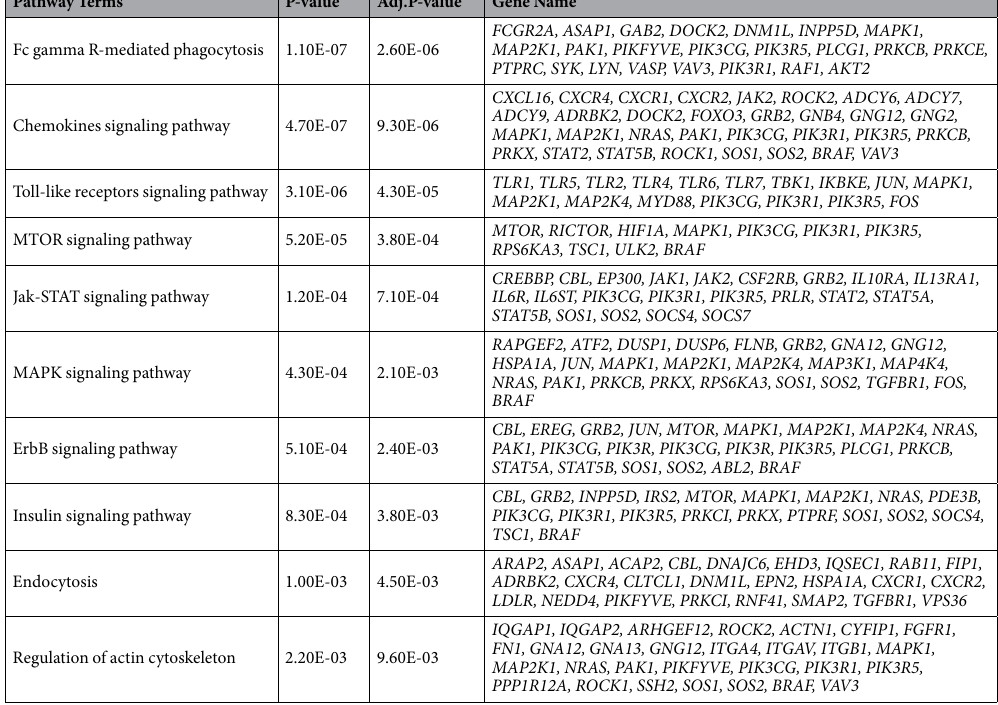
RNA, Myeloid-Specific 1) 26 , DANCR (Differentiation Antagonizing Non-Protein Coding RNA) 27 , GAS5 (Growth Arrest Specific 5) 28 , LINC-PINT (Long Intergenic Non-Protein Coding RNA, P53 Induced Transcript) 29 , HEIH (Hepatocellular Carcinoma Associated Transcript) 30 and RMRP (RNA Component Of Mitochondrial RNA Processing Endoribonuclease) 31 which were upregulated and, TUG1 (Taurine Upregulated 1) 32 , which was down- regulated in XLA patients compared to the healthy subjects. In addition, expression of the 20 DE novel lincRNAs were identified between XLA patients and healthy subjects. Among the 20 DE novel lincRNAs, 5 lincRNAs were upregulated and 15 lincRNAs were downregulated in XLA patients compared to healthy subjects, respectively (Supplementary Table S4). DE lncRNAs co-located with protein-coding genes. lncRNAs have been reported to coordinate the regulation of neighboring protein-coding genes (co-located genes). To identify the potential function of the identified DE lncRNAs, the protein-coding genes which genomic locations within ~5 kb upstream and ~1 kb downstream of the DE lncRNAs and which may extend to 1000 kb in both directions were searched. The anal- ysis revealed that out of 95 DE annotated lncRNAs, 85 lncRNAs were corresponded to 144 protein-coding genes. Moreover, among the 20 DE novel lincRNAs, 18 novel lincRNAs were linked to 28 protein-coding genes (Supplementary Table S5). Majority of DE lncRNAs region-gene associations were found to be dis- tal binding events while approximately only 9% regions were within 5 kb of transcription start sites (TSS) (Supplementary Fig. S1). Next, the function of DE lncRNAs was examined based on GO enrichment and KEGG pathway analysis of their co-located genes (Fig. 4, Supplementary Table S2). The GO enrichment analysis based on biological process demonstrated that the DE annotated lncRNAs co-located genes were mainly involved in “reproductive process”, “positive regulation of cell proliferation” and “induction of apoptosis by extracellular signals” (Fig. 4a). On the other hands, the DE novel lincRNAs co-located genes were related to “regulation of cell differentiation” and “regulation of cell activation” (Fig. 4b). The KEGG pathway analysis revealed that the DE annotated lncRNAs co-located genes were significantly involved in “Metabolic pathways”, and “Cytokine- cytokine receptor interac- tion” (Fig. 4c). While the novel lincRNAs co-located genes were related to “Focal adhesion” and “Regulation of actin cytoskeleton” (Fig. 4d). Besides that, we examined whether any DE lncRNAs co-located genes was differentially expressed in XLA patients compared to healthy subjects. The comparison of the DE annotated and novel lncRNAs co-located genes with DE protein-coding genes led to identification of 23 genomically co-located DE protein-coding genes (Supplementary Table S6). For instance, DE annotated lncRNAs; HOTAIRM1 , DANCR and GAS5 were co-located with DE protein-coding genes: HOXA1 , USP46 , ZBTB48 respectively, which are involved in regulating the gene expression, morphogenesis and differentiation, ubiquitin protease activity, and MHC II promoter compotes. The results also indicated that DE novel lincRNAs TCONS_00030433 , TCONS_00041961 and TCONS_00295657 were co-located with DE protein-coding genes VAV3 (Vav Guanine Nucleotide Exchange Factor 3) - involve